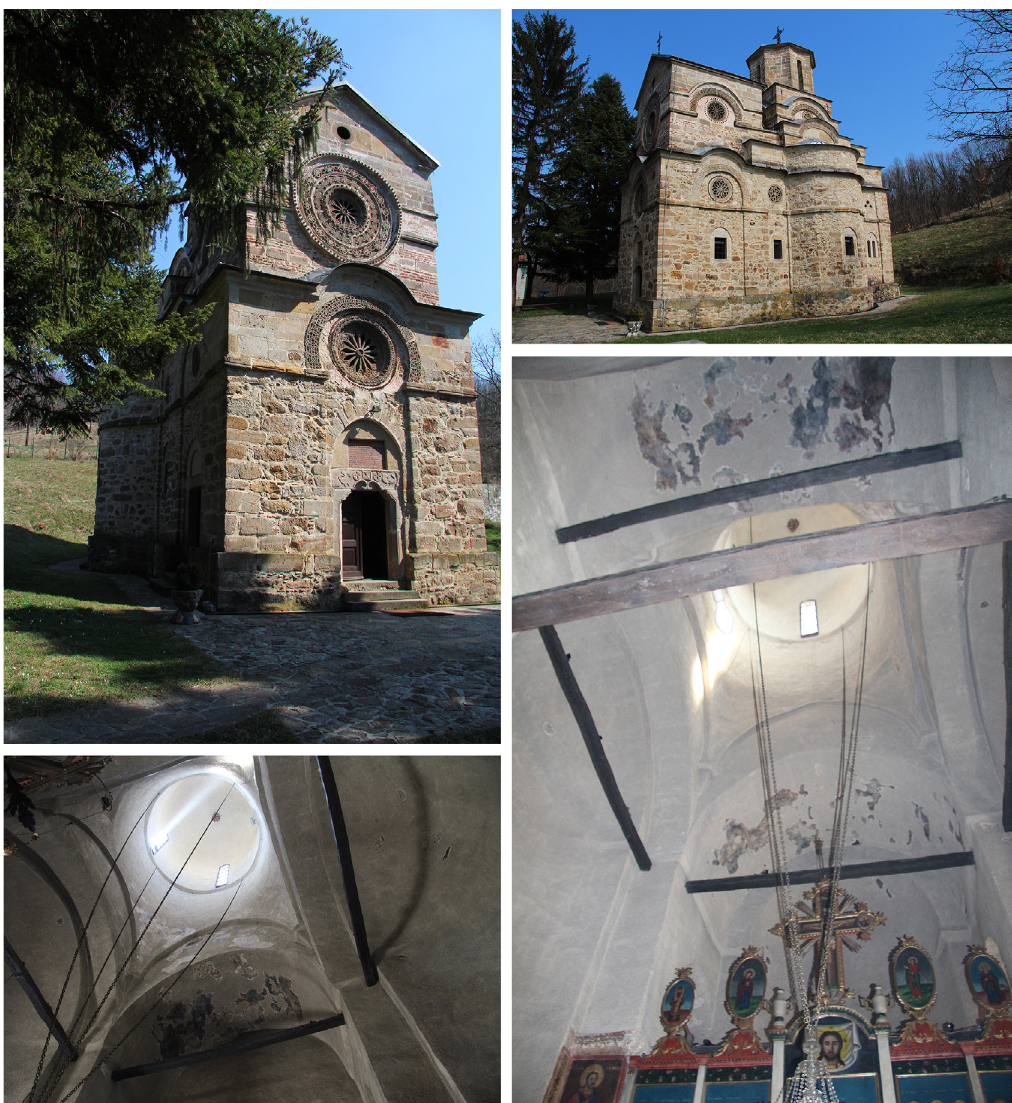
Figure 2. Temple of the Birth of the Holy Mother, Naupara monastery: exterior view (top) and interior view of the naos and central dome (bottom) where wooden iconostasis and fresco remains could be observed. Photo credits: Zorana